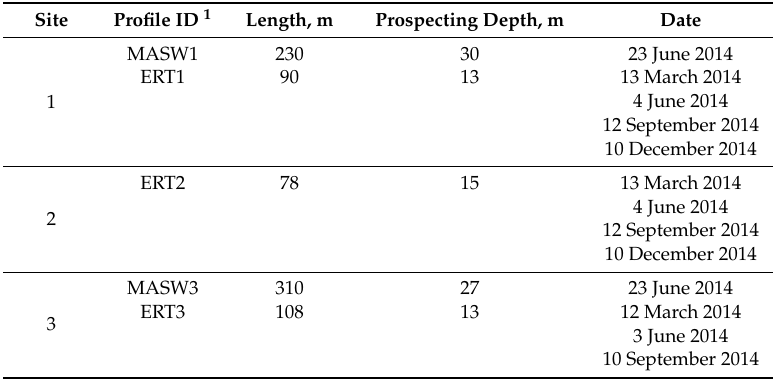
Table 2. Description of MASW and ERT